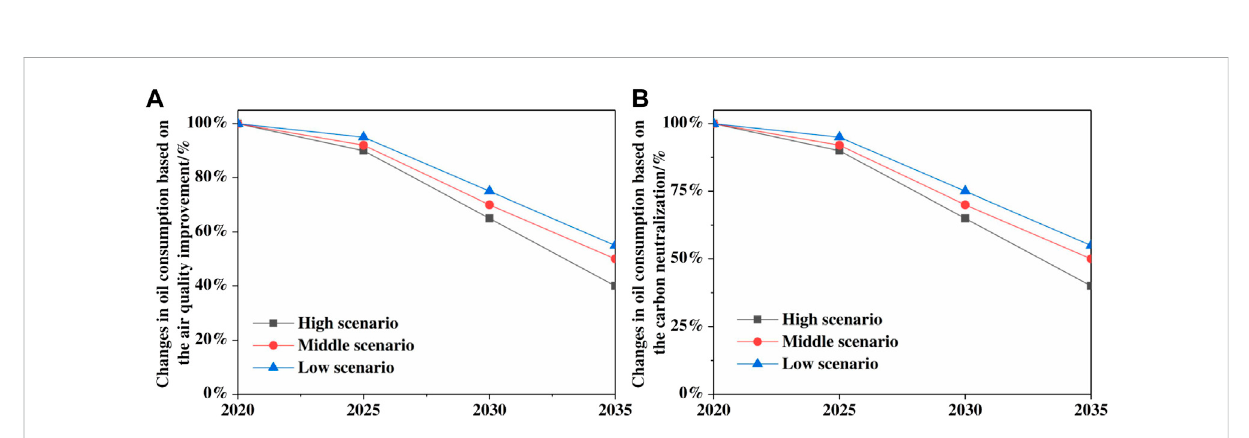
FIGURE 5 Changes in fuel consumption due to air quality improvement (A) and carbon neutrality (B)